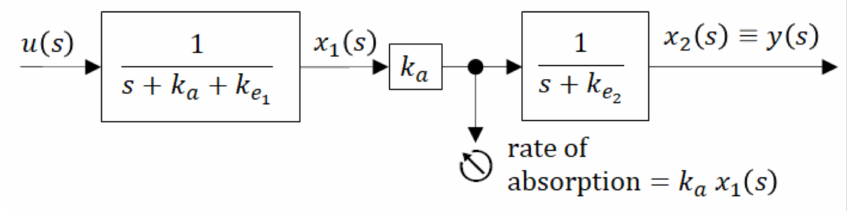
Figure 6. Block scheme with partial transfer functions of the compartment model